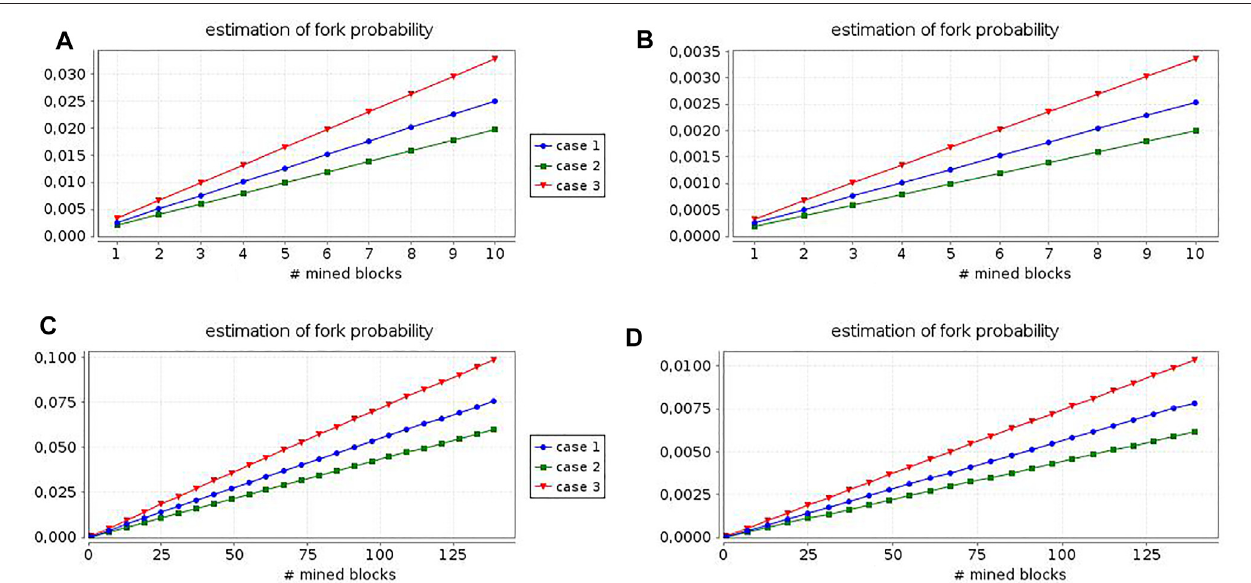
FIGURE 2 | Relation between blockchain length and fork likelihood: analysis for 4 different